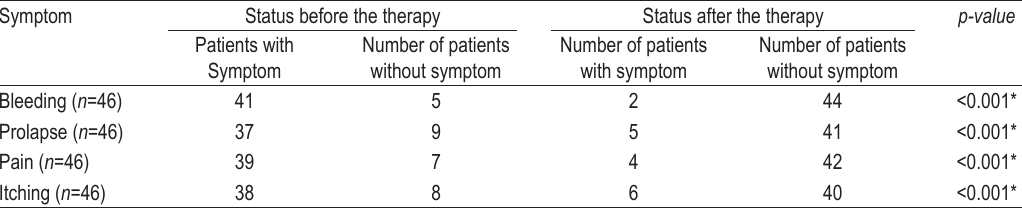
TABLE 2. Patients with and without the analyzed symptoms (bleeding, prolapse, pain, and itching) before and after the therapy Symptom Status before the therapy Status after the therapy